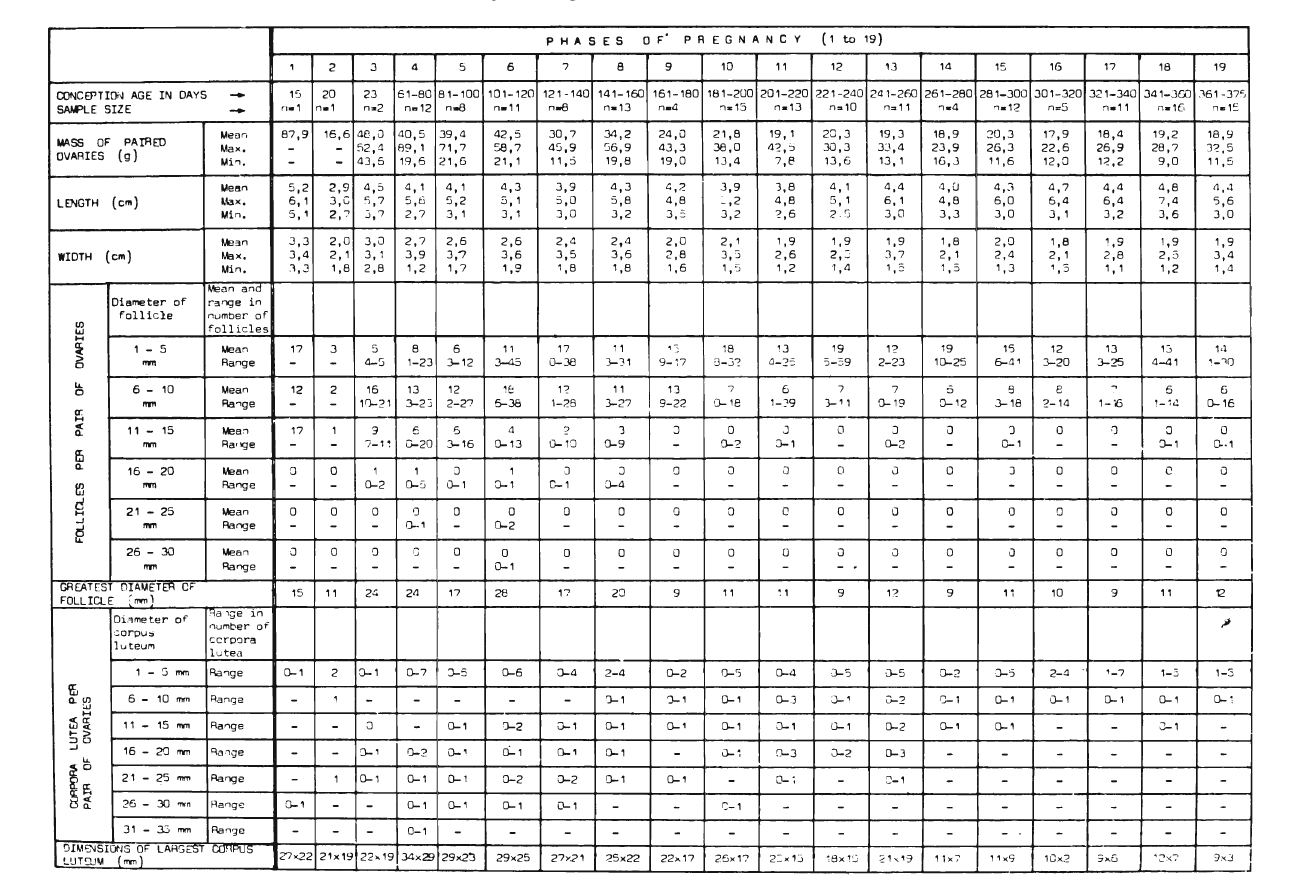
Data collected _from "lacroscopical sections made on J 7:2 pairs €if ovaries from Burchell ~s z.ebra at various _'tages of pregnancy. Data have been grouped into 19 arbitrary pregnancy phases and means, maxima and minima for various parameters of each phase calculaJed. All mares were shot in the Central District of the Kruger National Park between 1969 and